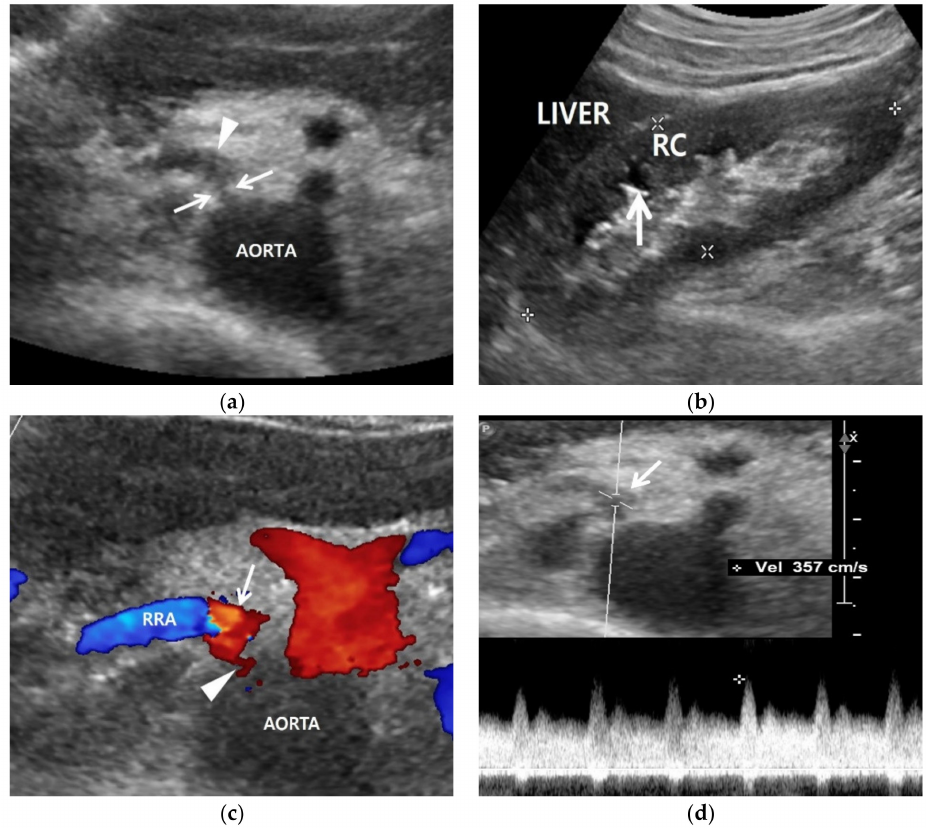
Figure 2. Renal artery and renal US examinations of a 50-year-old man. ( a ) Gray-scale US axial image shows focal stenosis (arrows) in the proximal right renal artery (RRA) and poststenotic dilatation (arrowhead). His RAS was incidentally detected in the routine check-up because his clinical or laboratory findings were unclear. ( b ) Gray-scale US sagittal image that shows a small (9 cm) right kidney in which the cortex (RC) is more hyperechoic compared with the liver parenchyma. Arrows indicate clear cortico-medullary differentiation in the right kidney. ( c ) Color Doppler US shows a focal stenosis (arrowhead) in the proximal renal artery. Bright red and blue signals are seen in the poststenotic dilatation (arrow). ( d ) Spectral Doppler US shows a high PSV (357 cm/s) in the poststenotic dilatation (arrow). However, a low PSV (108 cm/s) was measured in the stenotic artery because the frequency shift from the RAS was not